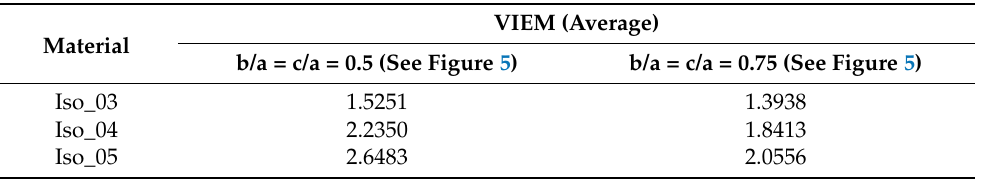
Table 15. Normalized tensile stress component ( σ xx / σ o xx ) within the isotropic oblate spheroidal inclusion due to uniform remote tensile loading ( σ o xx